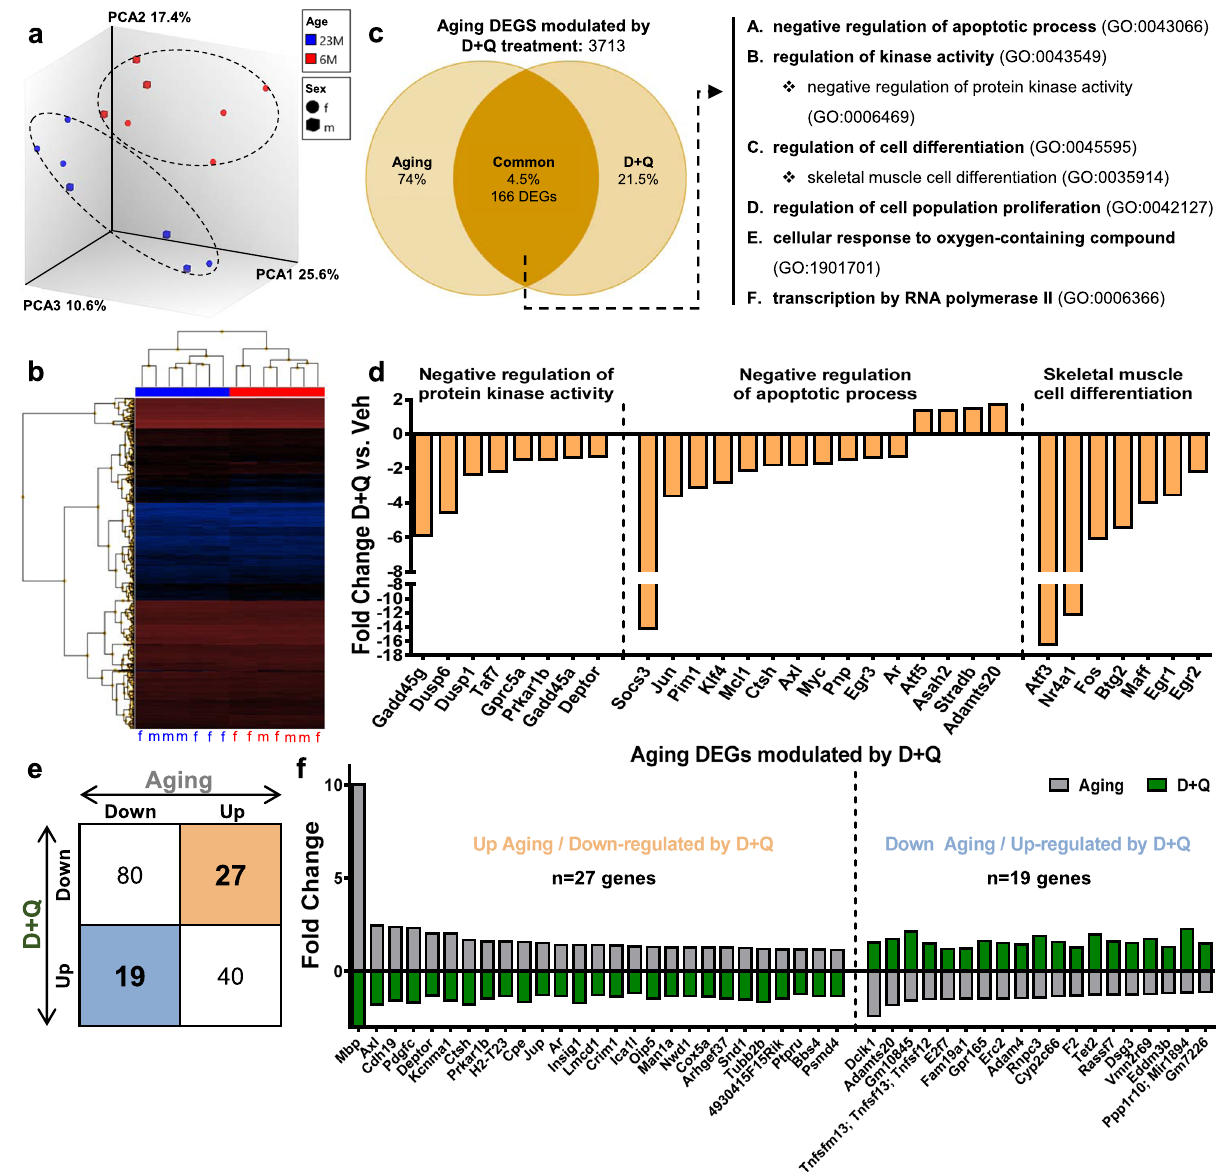
Fig. 6 D + Q modulates aging-associated DEGs related to negative regulation of apoptotic process, regulation of kinase activity and regulation of cell differentiation pathways. a , b PCA and hierarchical clustering of transcriptomic signature from 23 M vs. 6 M BL6 NP of deposited data in GSE134955, p < 0.05 28 . c Venn diagram from intersection analysis of aging and D + Q modulated DEGs and the representative GO processes associated with the 166 common DEGs. d Representative common DEGs from selected GO processes from panel C. e Schematic of common DEGs showing directionality of change in each experiment study (Aging vs. D + Q). f Representative DEGs with opposite modulation between aging and D + Q selected from panel e . p - values were calculated using eBayes ANOVA Method (unadjusted). GO analysis was performed using the PANTHER Overrepresentation Test with GO Ontology database annotations and a binomial statistical test with FDR ≤ 0.05. Source data are provided as a Source Data fi